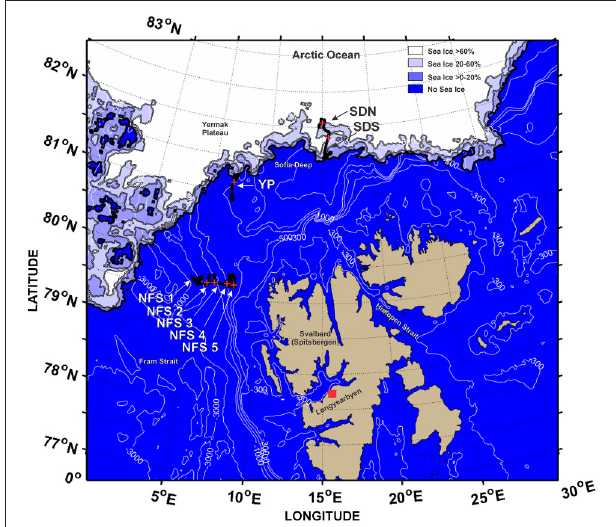
FIGURE 1 | Cruise tracks of R/V Helmer Hanssen during the SI_ARCTIC 2015 cruise. Locations where day/night differences in the depth of the weighted mean acoustics data in the mesopelagic layer were compared are shown as black lines and + show location of CTD casts used in this study. The arrows point to eight locations: Sofia Deep N (SDN), Sofia Deep S (SDS), Yermak Plateau (YP), Northern Fram Strait 1 (NFS 1), Northern Fram Strait 2 (NFS 2), Northern Fram Strait 3 (NFS 3), Northern Fram Strait 4 (NFS 4), and Northern Fram Strait 5 (NFS 5). The figure uses the AMSR2-Based Sea Ice Concentrations on 30 August 2015 when the Helmer Hansen was conducting work at the ice edge. The Sea Ice data were obtained from ftp://ftp-projects. cen.uni-hamburg.de/seaice/AMSR2/3.125km/ (Kaleschke and Tian-Kunze (2016). See Beitsch et al. (2014) for a description of the analysis